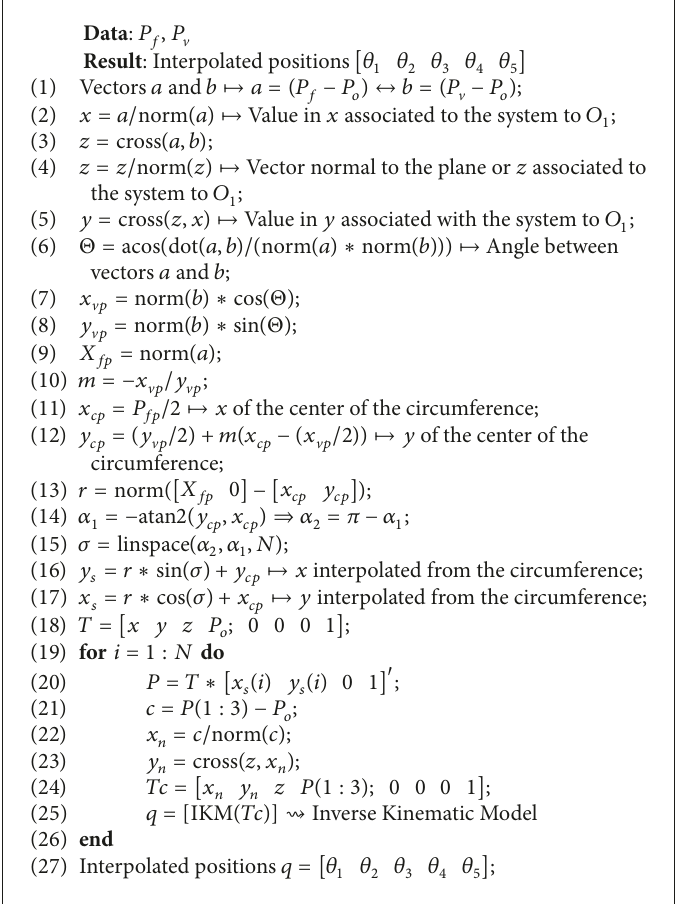
Algorithm 3: Algorithm for joint movement of MOVEC.